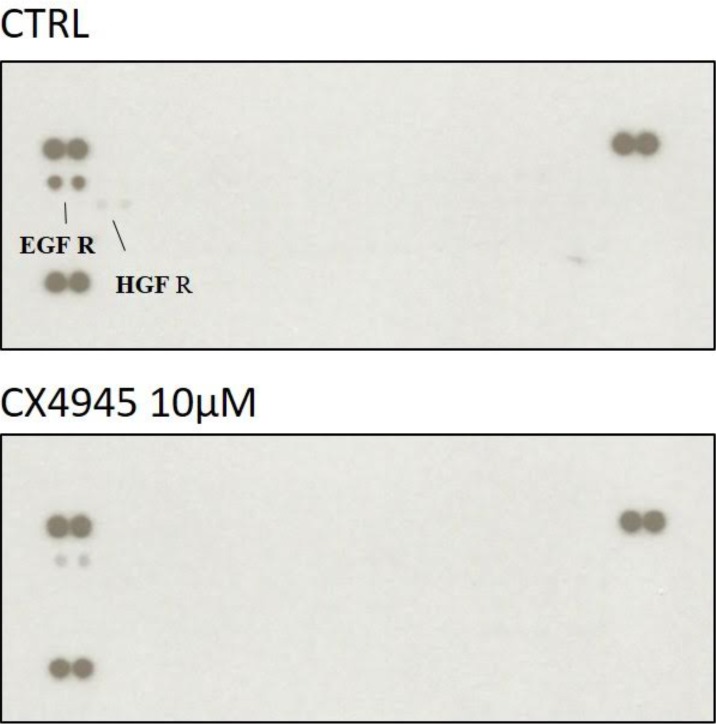
RTK human phosphoarrays in mucin-IHCCA cells resistant to CX4945 treatment.After 72h of CX4945 (10 μM) treatment, surviving cells showed contemporary deactivation of both EGFR and HGFR signalling. The black lines indicate the spots positive for EGFR and HGFR activation.